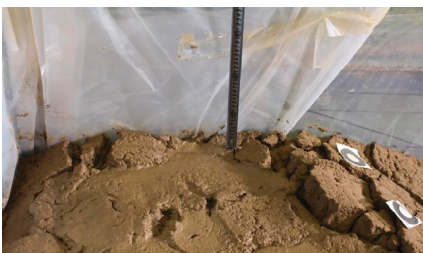
Figure 22: Loess slope surface at the